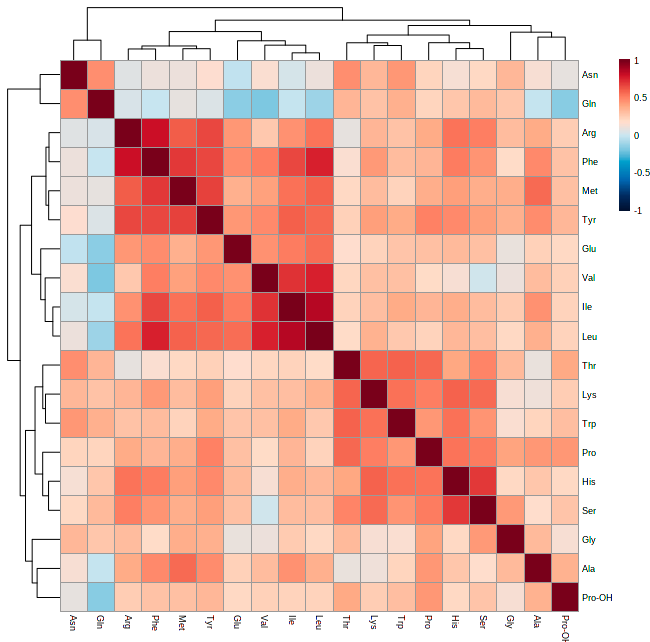
Figure 6. Overall Spearman’s correlation heatmap for studied amino acids in pregnant NGT and GDM women ( n = 64).